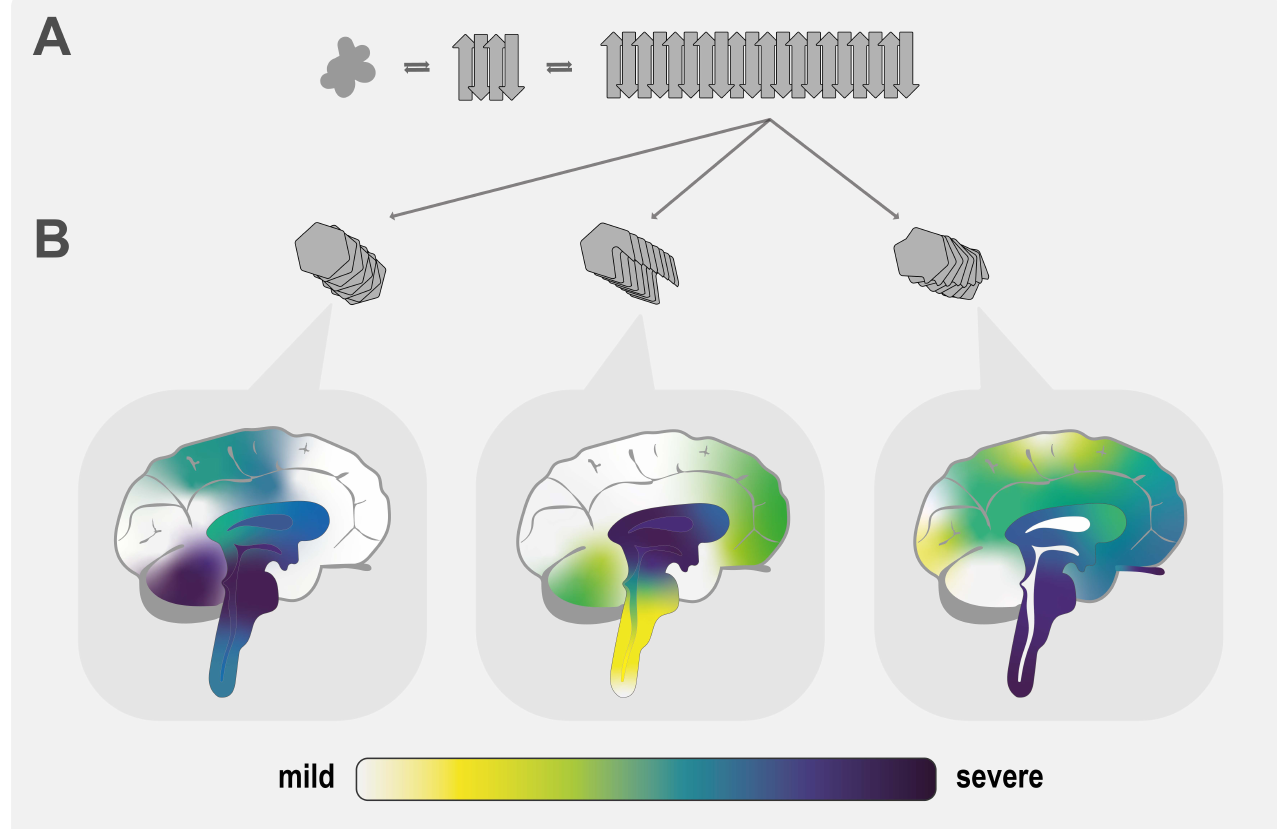
Figure 1. Graphical representation of the prion strain hypothesis: ( A ) a natively folded protein can acquire a β -sheet-rich conformation capable of templating misfolding of other native monomers; by incorporating additional monomers, oligomers form that further grow into amyloid fibrils; ( B ) the same native monomer can adopt various β -sheet-rich conformations; therefore, distinct three-dimensional fibril structures composed of differently folded subunits can arise. Following the prion strain hypothesis, these amyloid fibrils of different conformations affect different parts of the brain in characteristic ways. Proteinaceous inclusions and cellular damage would occur to varying degrees in different areas of the brain (yellow/mild →